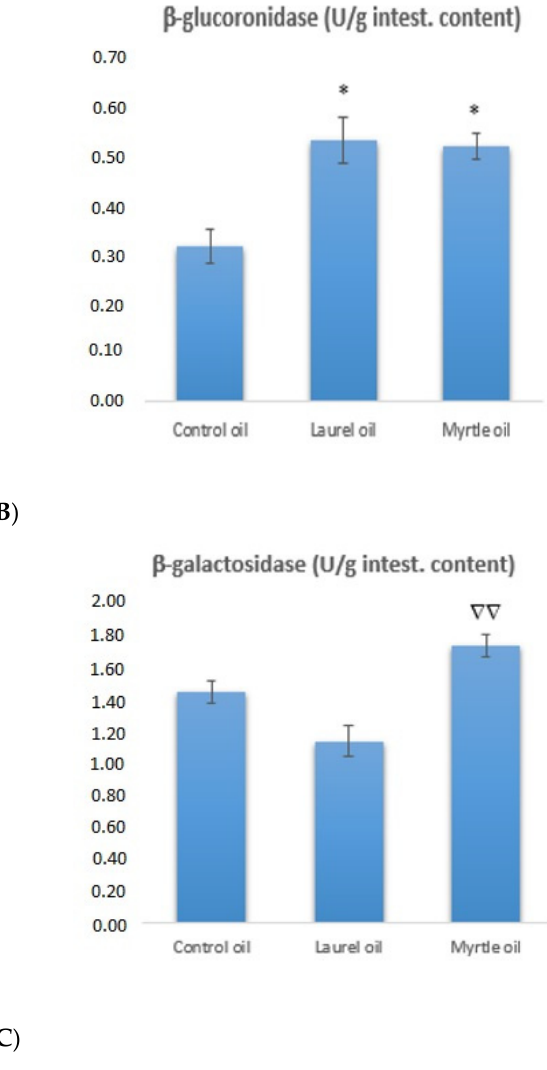
Figure 5. Activity of the bacterial enzymes β -glucosidase ( A ), β -glucuronidase ( B ) and β -galactosidase ( C ) in the colon contents of rats treated with laurel and myrtle EOs. Female rats ( n = 5) were administered ig with laurel and myrtle EOs at a dose of 1 μ L per 1 g of rats once daily for 14 days. Laurel and myrtle EOs were mixed with sunflower oil (1:1) and the total daily volume per rat was 0.5 mL. The control group was treated ig with 0.5 mL of sunflower oil. The results are expressed as the mean value of each experimental group ± SEM. * Significantly different in relation to the control group (* p < 0.05); ∇ Significantly different in relation to the laurel-EO-treated group ( ∇∇ p < 0.01). Δ Significantly different in relation to the myrtle-EO-treated group ( Δ p < 0.05). Abbreviations: intest., intestinal.